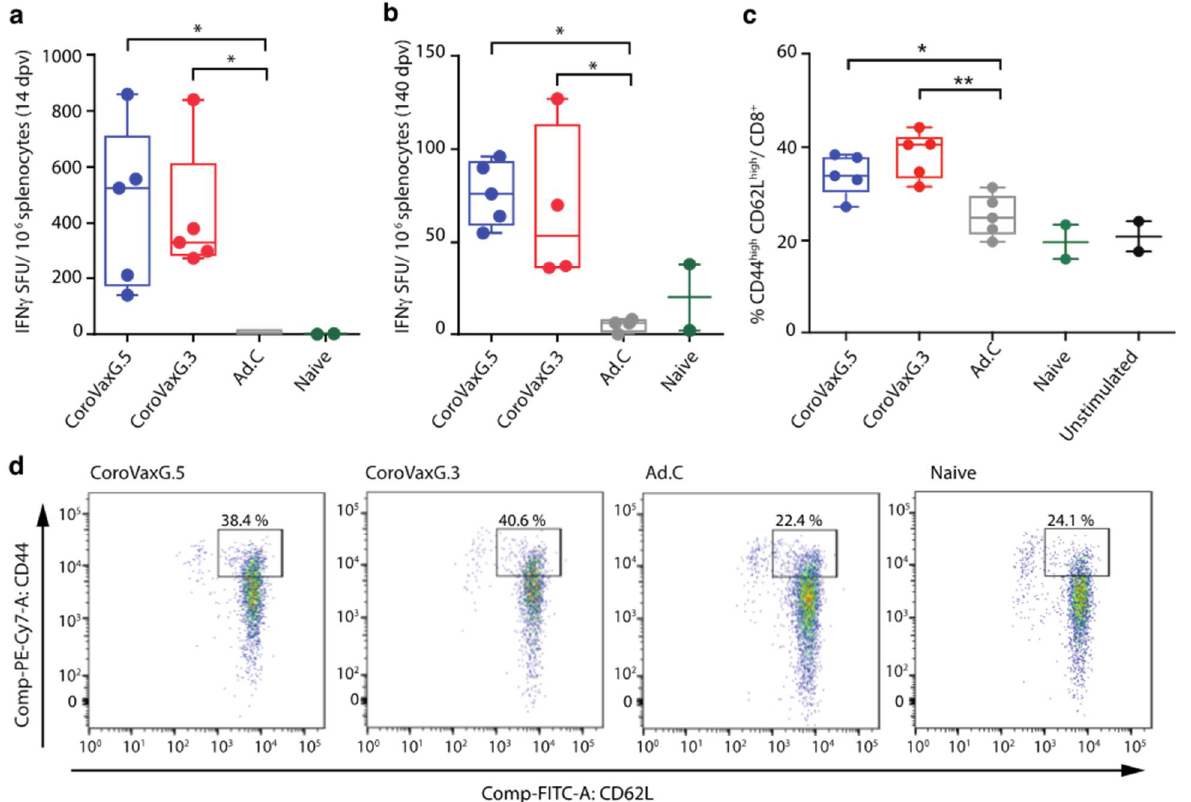
Figure 4. Cellular immune response induced by Ad-vectored vaccines. BALB/c mice received 10 9 or 10 10 vp of an Ad-vectored vaccine (blue: CoroVaxG.5; red: CoroVaxG.3; grey: Ad.C; green: Naïve) and were sacrificed after 14 days (10 10 vp) or 140 days (10 9 vp). Cells secreting IFN- γ per million of splenocytes were determined by ELISPOT at ( a ) 14 days. ( b ) 140 days post-immunization. The samples were analyzed in duplicates. The results of each group are expressed as the mean of spot-forming units (SFU). For FACS analysis, splenocytes were stained with anti-CD8 α , anti-CD62L and anti-CD44 fluorochrome-conjugated antibodies. Stained splenocytes were subjected to flow cytometry analysis to quantify memory T cells (TCM: CD44high CD62Lhigh and TEM: CD44high CD62LLow) ( c , d ). ( c ) Data are expressed as percentage of total CD8+ cells; unstimulated controls (black dots) were included. ( d ) Representative dot plots of each group. The gate shows TCM subpopulation. The box and whisker plots represent the median (mid-line), max and min (boxes) and range (whiskers). The percentage of TCM cells in each group is depicted in the upper part of the box. Vaccinated groups were always significantly different to the Naïve and Unstimulated group; * p < 0.05, ** p < 0.01; Kruskal–Wallis test with Dunn’s multiple comparisons a posteriori